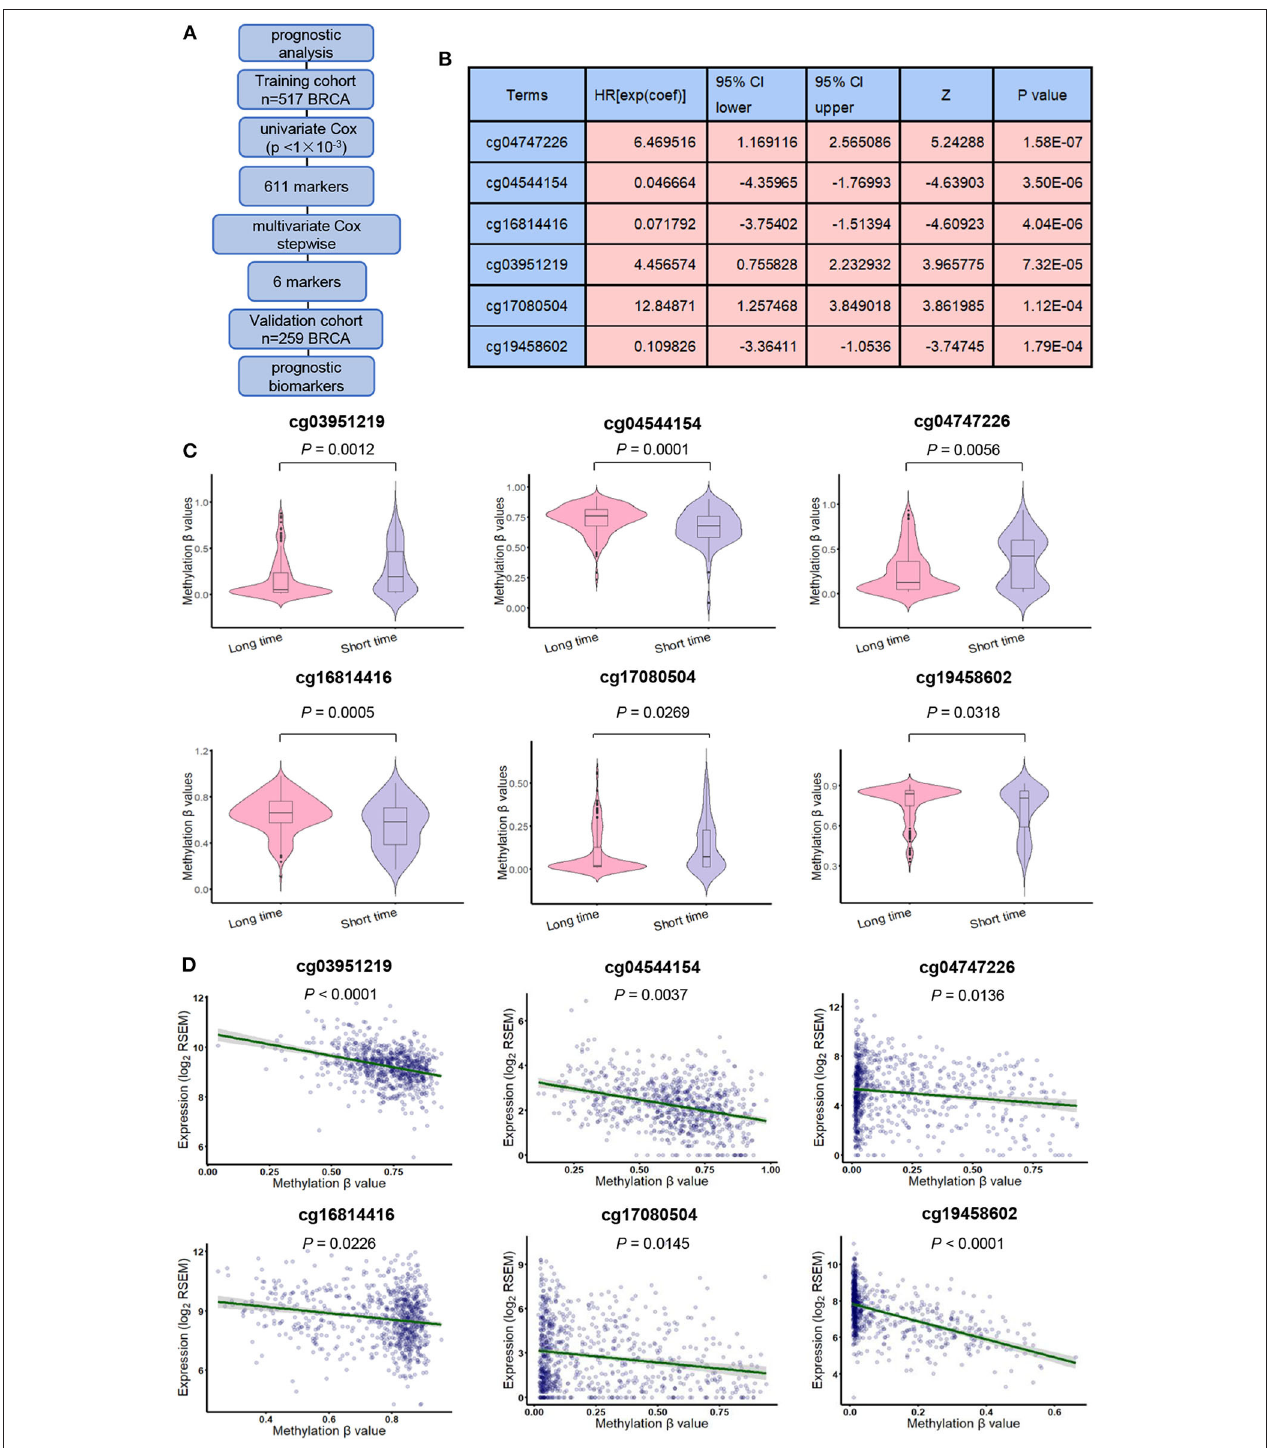
FIGURE 4 | Derivation of prognostic DNA methylation markers. (A) The flowchart for finding BRCA candidate prognostic biomarkers. (B) General characteristics of univariate Cox regression analysis of six methylation biomarkers. (C) methylation β values in short survival (OS < 5 years) patients and long survival (OS > 5 years) patients. (D) Pearson correlation test was used to evaluate the correlation between gene expression and methylation level.